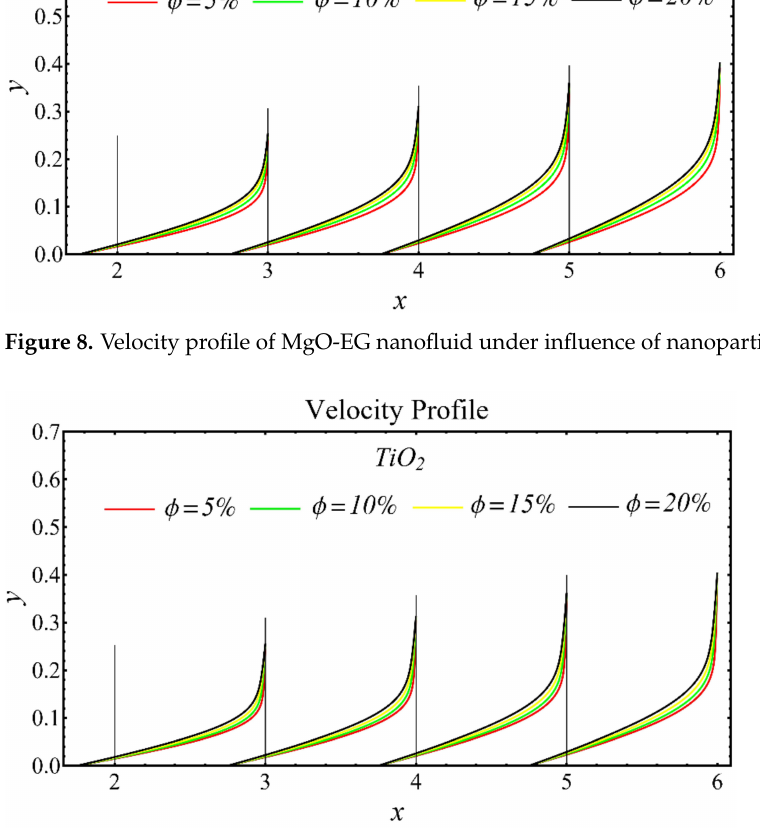
Figure 9. Velocity profile of TiO 2 -EG nanofluid under influence of nanoparticle concentration. The velocity profiles of the schematic nanofluids under the effect of two distinct nanoparticle diameters are shown in Figures 10–12. It is clear that the velocity profile is increased by increasing the nanoparticle diameter due to the decline in the viscosity of the nanofluids. In addition, the dominant impact of this parameter on the profile is found to be more pronounced in the MgO-EG nanofluid than in the other nanofluids.